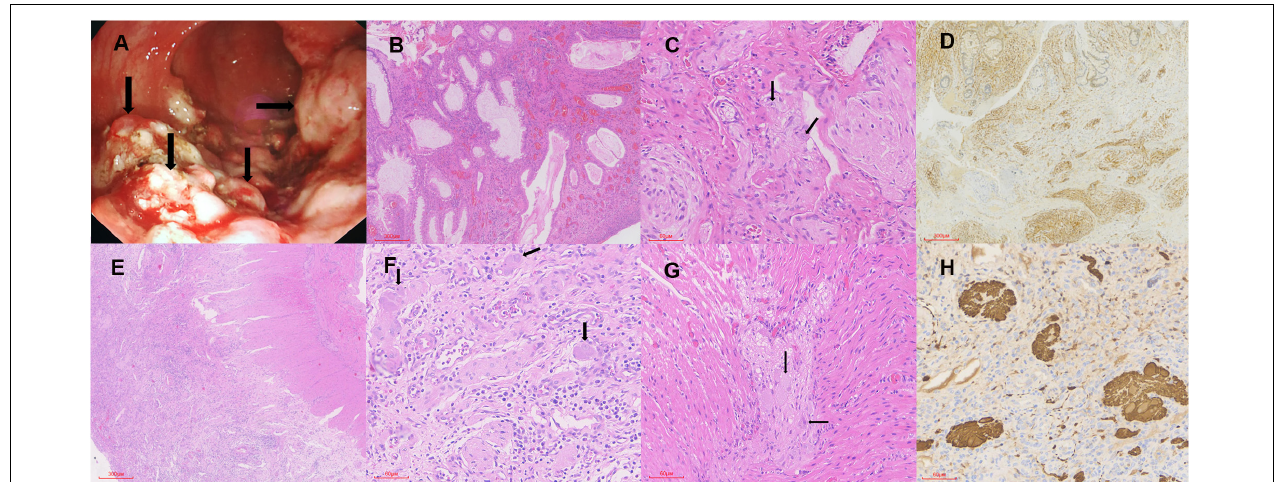
FIGURE 1 | The endoscopic and pathological findings. (A) Multiple polyps (arrows) with paving stone-like changes in the descending colon. (B) Gland hyperplasia, cavity expansion, interstitial blood vessel hyperplasia, and neutrophil infiltration in the lesions (H&E × 40). (C) Nerve fibers, Schwann cells, and scattered ganglion cells (arrows) in the proliferated nerve plexus (H&E × 200). (D) The neoplastic hyperplasia is positive for S-100 (IHC × 40). (E) Significant inflammatory exudation and necrosis of the mucosal layer of the intestinal wall (H&E × 40). (F,G) The nerve plexus in the submucosa and myenteric is significantly proliferated and enlarged, with ganglion cells (arrows), nerve fibers, and Schwann matrix included (H&E × 200). (H) The neural elements are positive for PGP9.5 (IHC ×